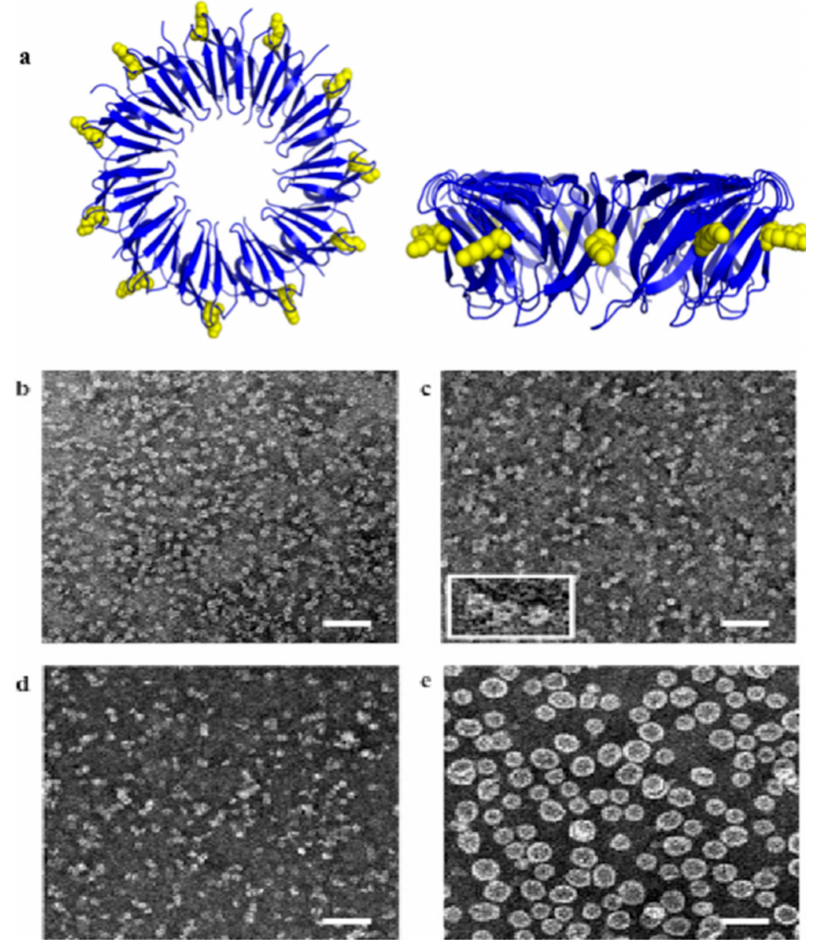
Figure 45. ( a ) The TRAP crystal structure (pdb 1qaw) revealed in two equally orthogonal views. Reprinted with permission from reference [303] Copyright 1999, Elsevier. The protein with residue at site 35 highlighted in yellow space filling as represented by the cartoon format; ( b ) TEM micrograph of the purified wild-type TRAP; ( c ) TEM micrograph of the purified cysteine-mutant TRAP; ( d ) TEM micrograph of the wild-type TRAP in the Au NPs presence; ( e ) TEM micrograph of the cysteine-mutant TRAP in the Au NPs presence. Note the form of bulky structures. Scale bars = 40 nm. ( b – e ) Reprinted with permission from reference [307], Copyright 2012,